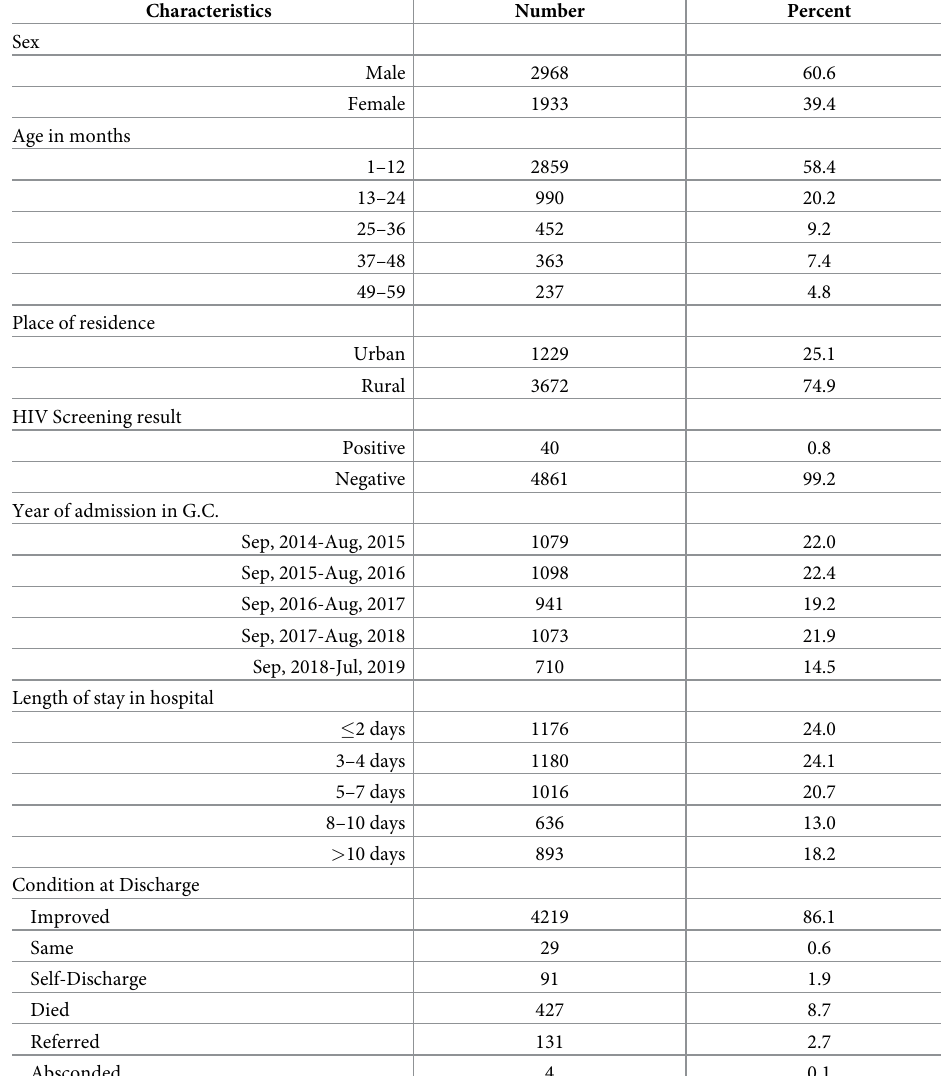
Table 1. Characteristics of the study participants admitted at Asella Referral & Teaching Hospital, January, 2020 G.C.